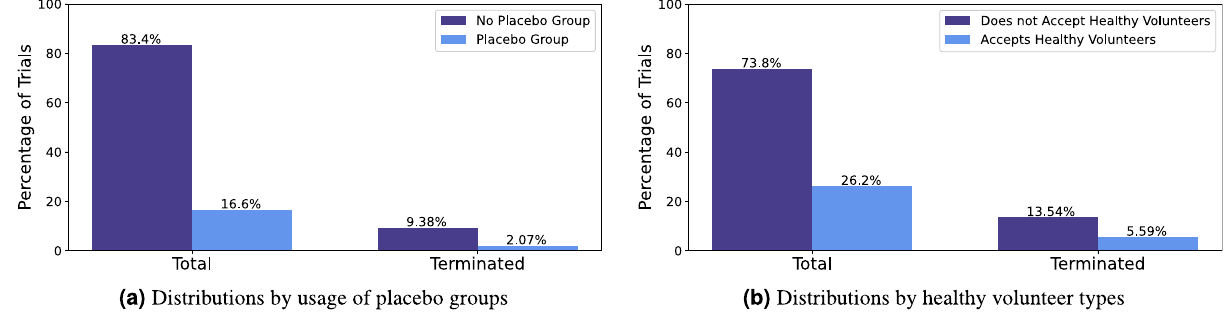
Figure 4. Distributions of clinical trials by placebo groups ( a ); and by volunteer types ( b